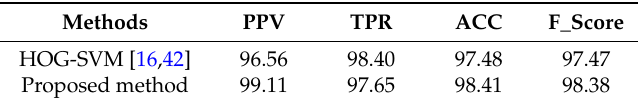
combined database (unit: